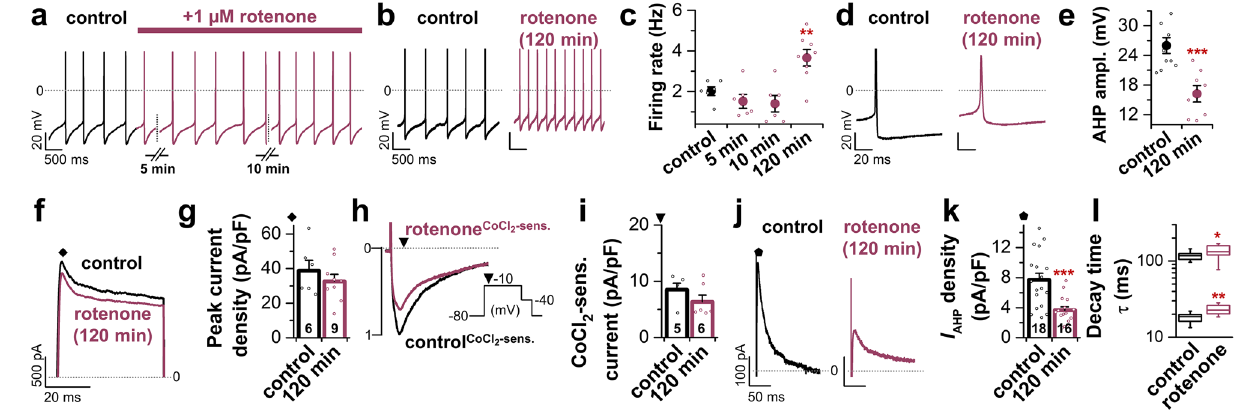
Figure 3. Electrophysiological alterations of LC neurons in an in vitro model of rotenone toxicity resemble those of αSyn overexpression. ( a ) Representative whole-cell spike train recording of a spontaneously active LC neuron in an acute brainstem slice derived from a C57BL/6 WT mouse. Wash-in of 1 µM rotenone after 2 min of stable firing tendentially, but not significantly, reduced the discharge rate of LC neurons within 10 min. ( b ) Example spike train recordings after slices were incubated for 2 h in standard ACSF (control, black) or ACSF + 1 µM rotenone (red) prior to recording. ( c ) Quantification of spontaneous firing 5 min (n = 6), 10 min (n = 6) and 2 h (n = 8) after exposure to 1 µM rotenone. Pre-incubation of slices in rotenone led to a significant acceleration of the spontaneous firing rate compared to control (n = 6). ( d ) Representative AP traces of a control LC neuron (black) and an LC neuron pre-incubated in rotenone (red). ( e ) Quantification revealed a significant reduction of the AHP amplitude of LC neurons in slices incubated with rotenone compared to slices incubated in control ACSF (control: n = 10, rotenone: n = 8). ( f ) Representative whole-cell voltage clamp recordings of